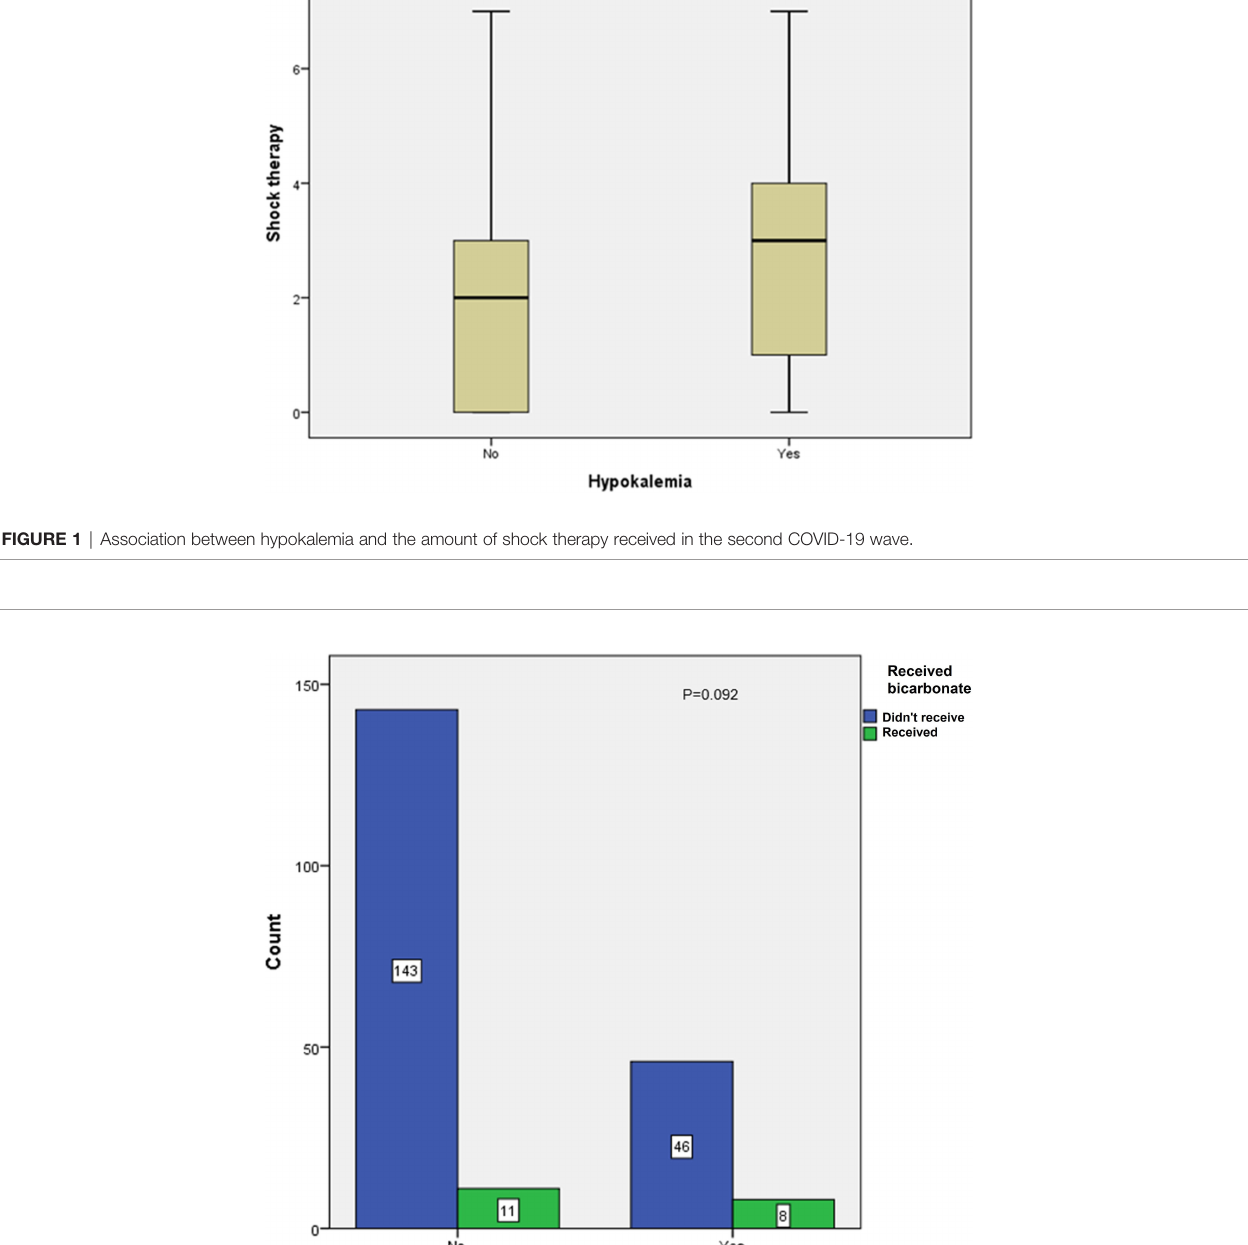
Frontiers in Endocrinology |